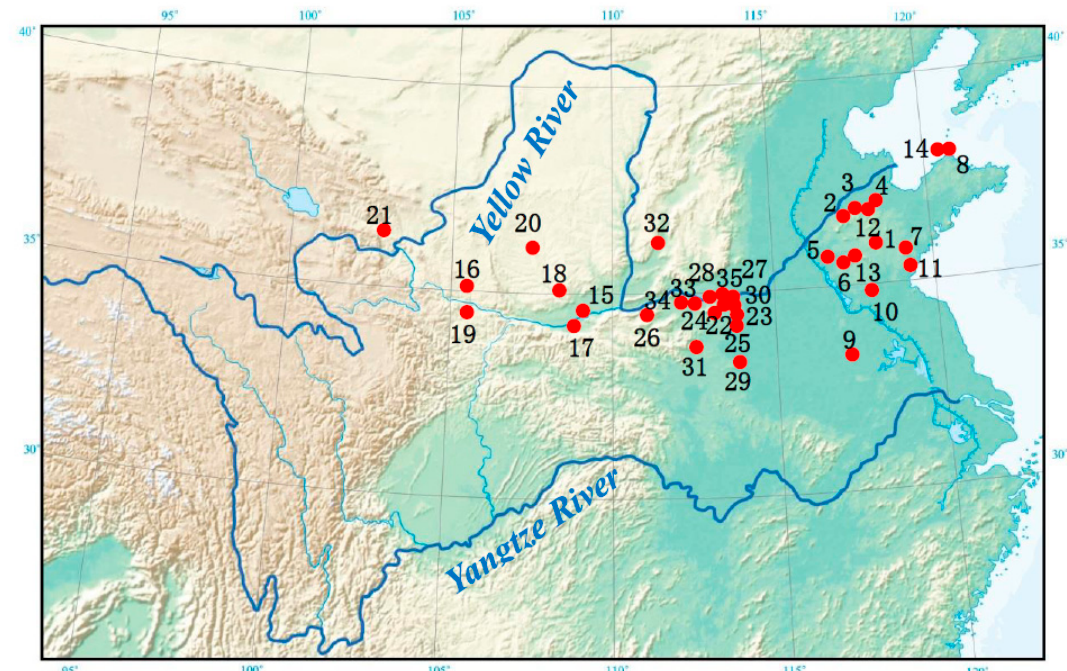
Figure 2. The location of typical sites with ancient house remains. (1) Bianbiandong; (2) Xihe; (3) Xiaojingshan; (4) Houli; (5) Dongjiabai; (6) Wangyin; (7) Chengzi; (8) Beizhuang; (9) Yuchisi; (10) Jianxin; (11) Yaowangcheng; (12) Fangjia; (13) Yinjiacheng; (14) Dakou; (15) Baijiacun; (16) Dadiwan; (17) Jiangzhai; (18) Lijiagou (Tongchuan); (19) Shizhaocun; (20) Chuangshan; (21) Lajia; (22) Lijiagou (Xinmi); (23) Tanghu; (24) Egoubeigang; (25) Shigu; (26) Xipo; (27) Dahecun; (28) Dianjuntai; (29) Haojiatai; (30) Guchengzhai; (31) Wadian; (32) Taosi; (33) Erlitou; (34) Zaojiaoshu; (35) Zhengzhoushang- cheng.